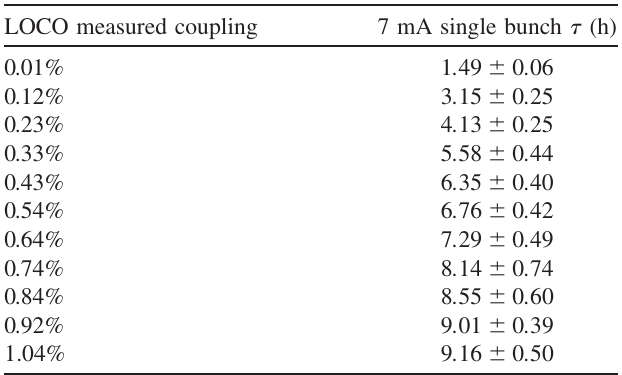
TABLE V. Measurements of Touschek lifetime for different coupling